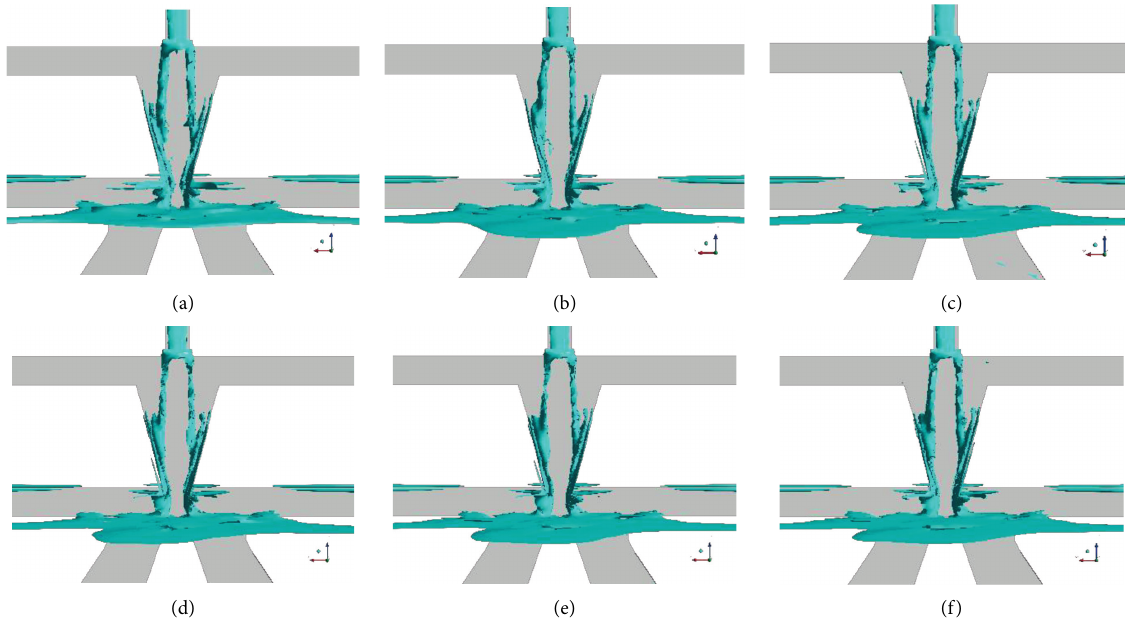
Figure 11: Vortex evolution process in the prestage. (a) t � t and (f) t � t 0 +1.6ms.